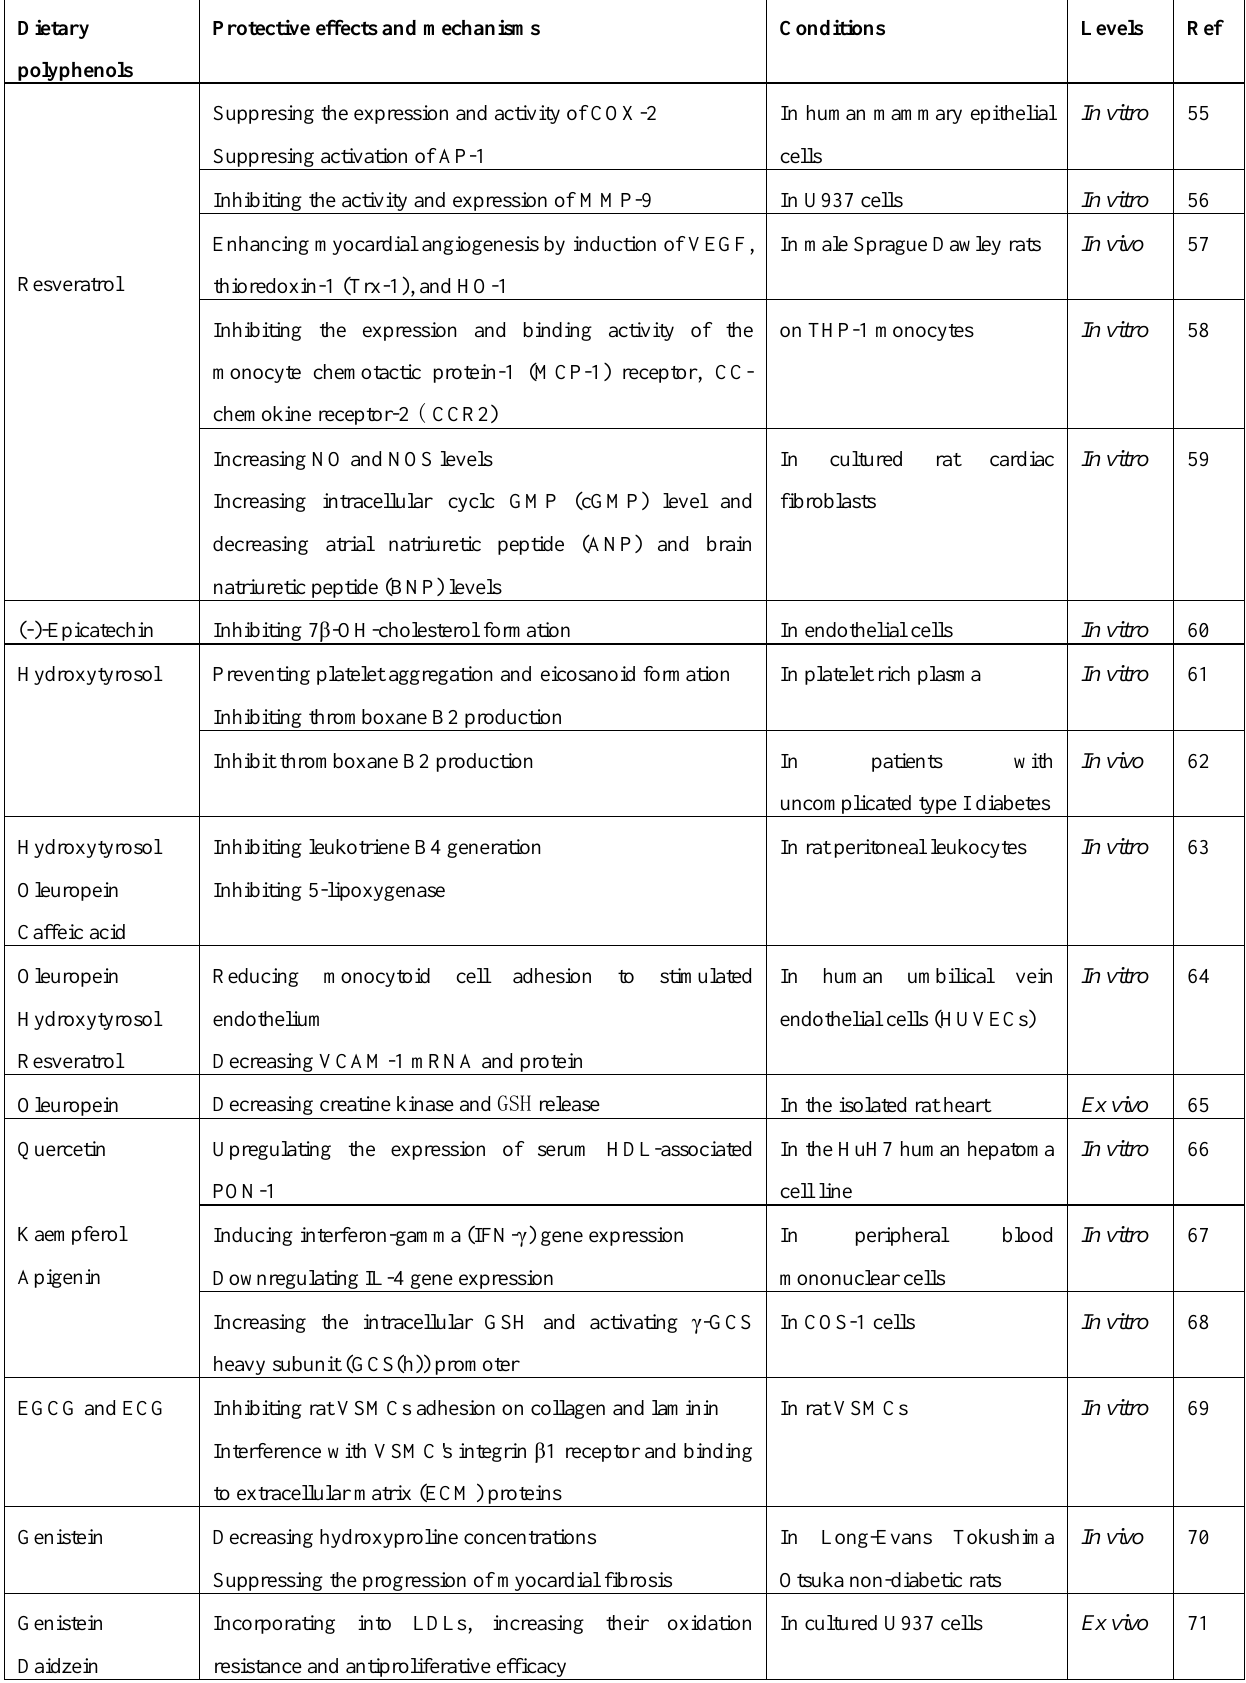
Table 3. Anti-atherosclerosis and cardioprotection of dietary polyphenols.